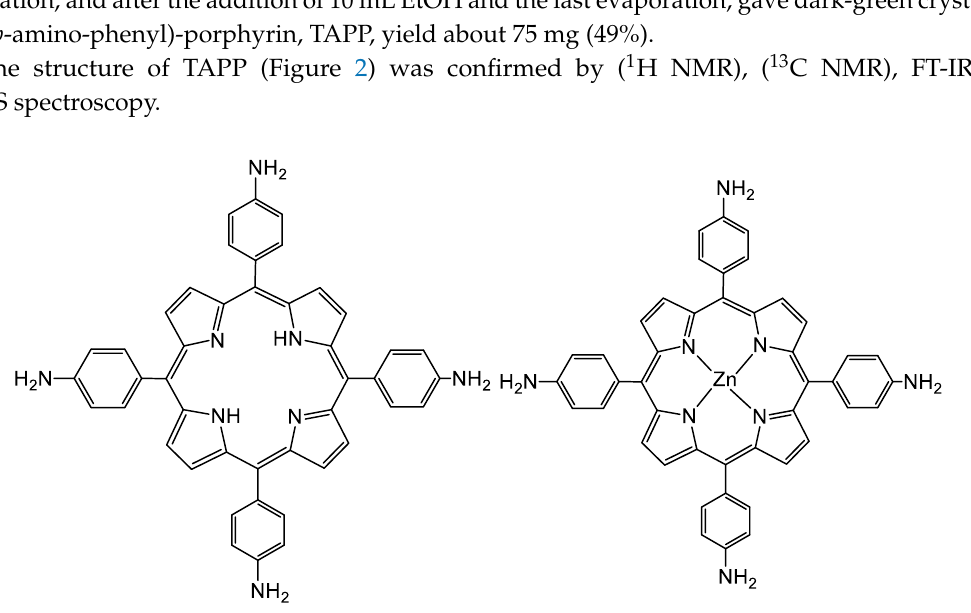
Figure 2. The chemical structures of TAPP and of ZnTAPP.